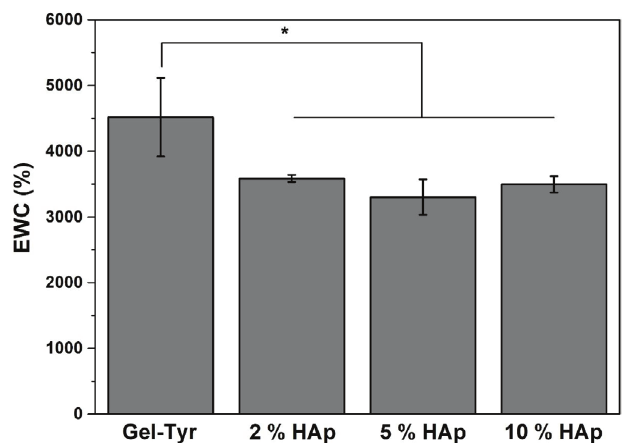
Fig. 5 – Equilibrium water content (EWC) of gelatine (Gel- Tyr) and Gel-Tyr/HAp composites with different HAp content (2